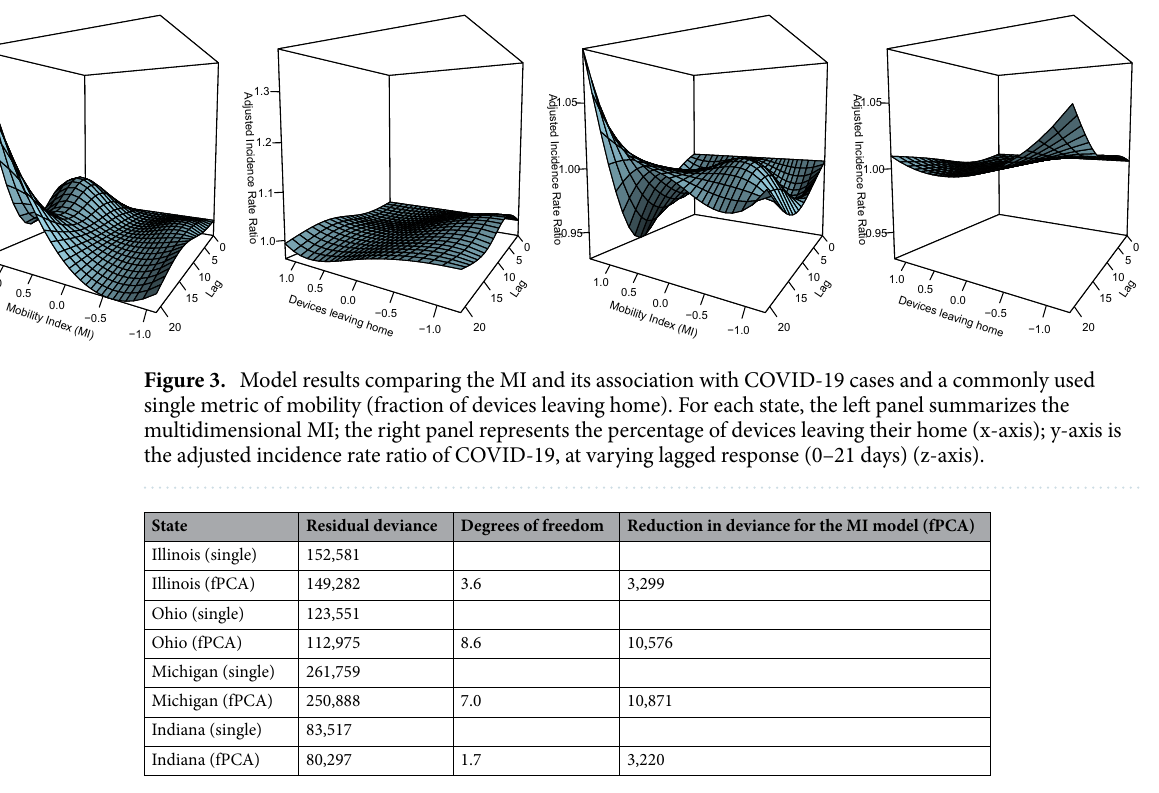
2 test statistic.